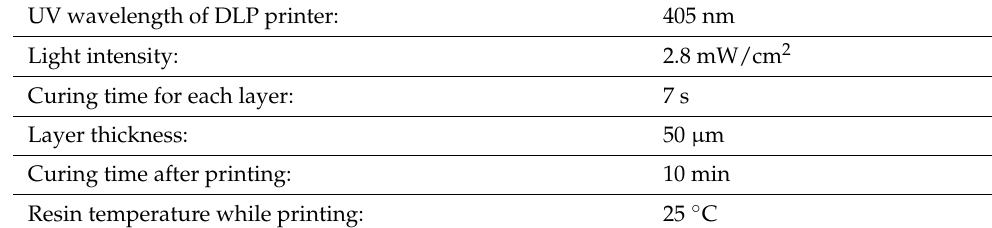
Table 1. All the DLP printing parameters used in the present work.